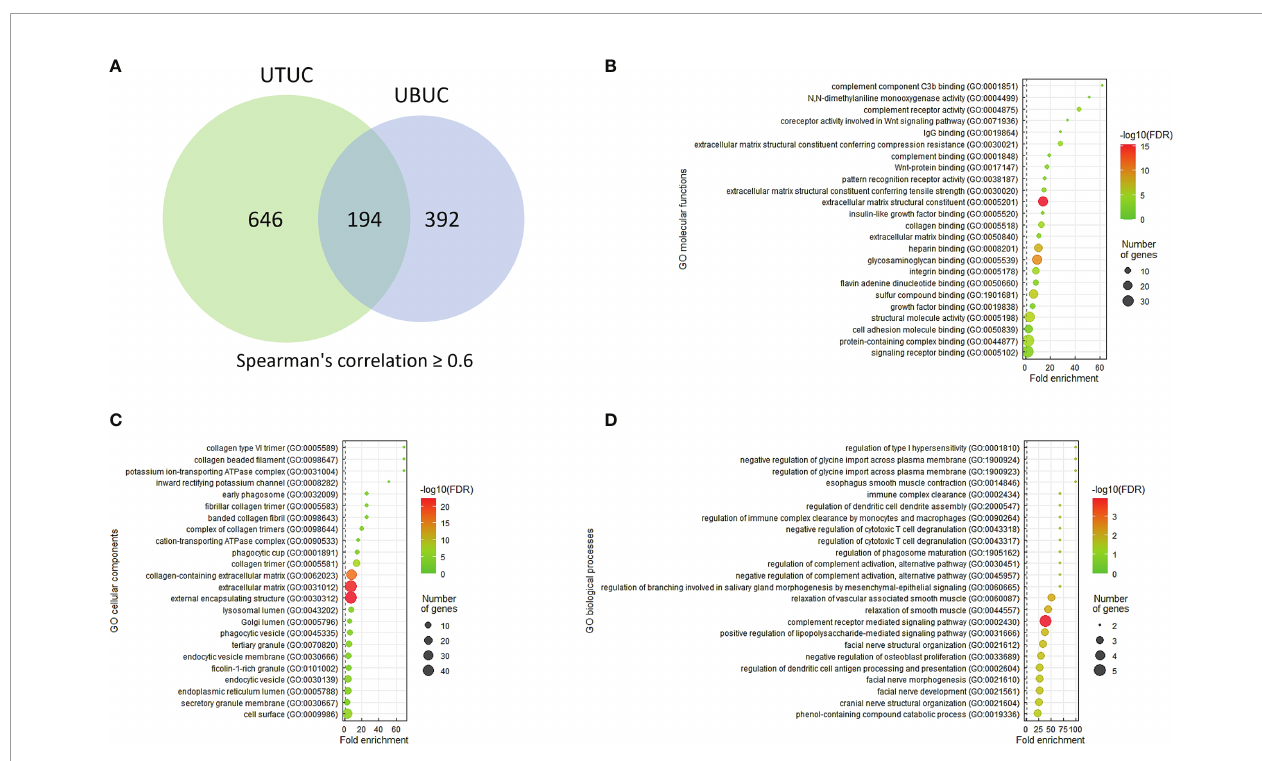
FIGURE 5 | The prominent GO terms enriched in SFRP2 upregulation. (A) The top 194 overlapping genes (Spearman ’ s correlation ≥ 0.6) co-upregulated with SFRP2 between UTUC and UBUC were examined utilizing the GO classi fi cation system according to (B) molecular functions, (C) cellular components, or (D) biological processes and were ranked by fold enrichment for functional annotation. To plot representative GO terms, an R script with ggplot2 package was